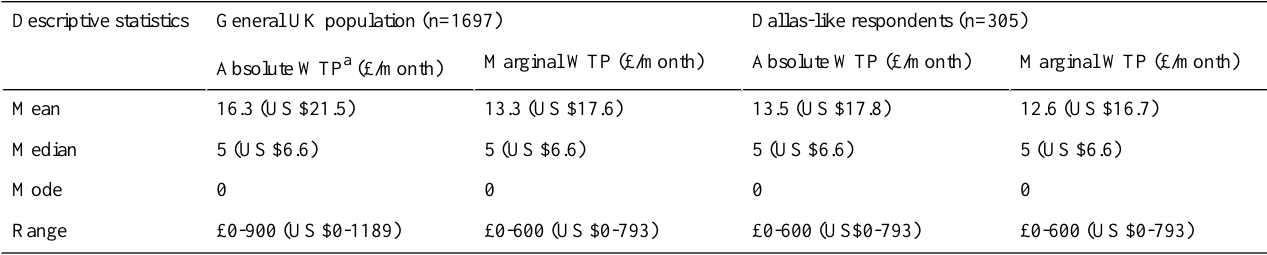
Table 2. Absolute and marginal